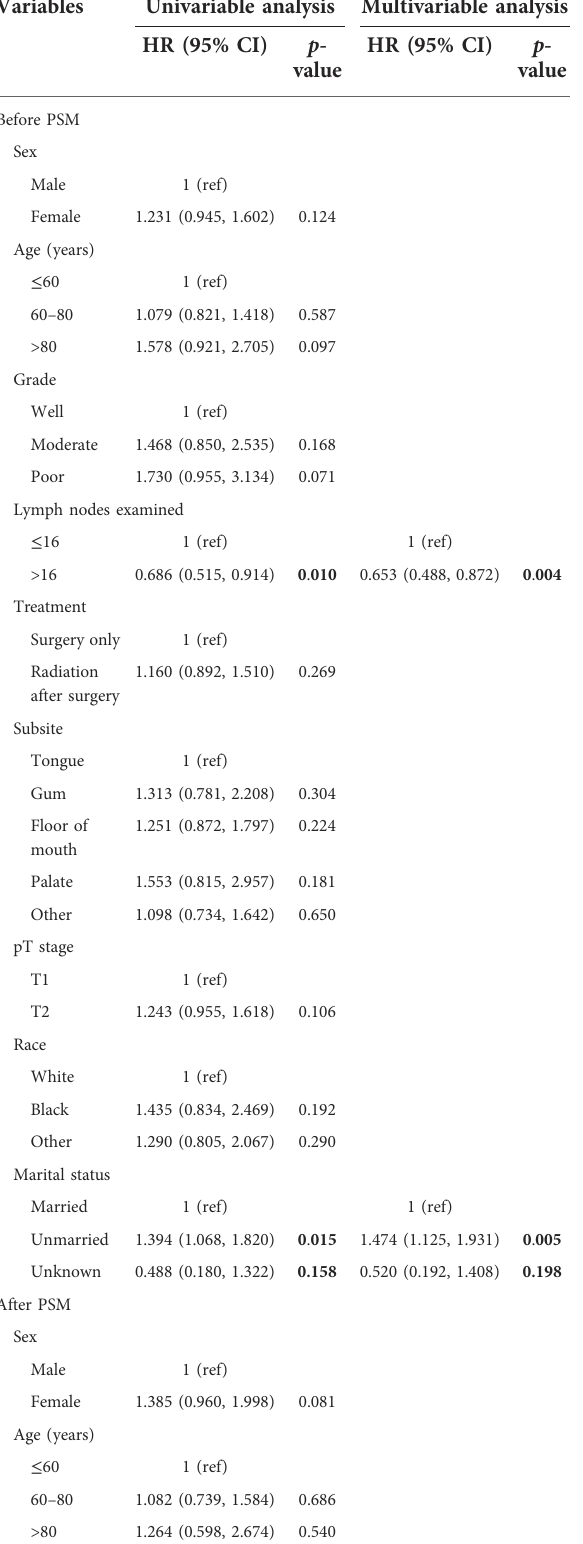
TABLE 2 Univariable and multivariable analyses of CSS by the Cox regression model before and after PSM.